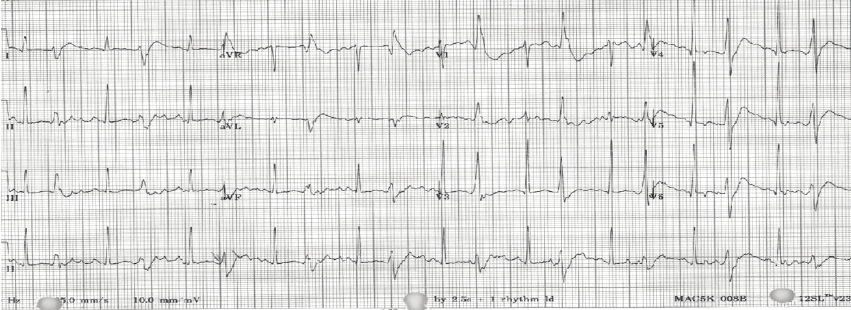
Figure 1: Initial EKG showing bigeminy—showing increased cardiac muscle excitability with origination of ventricular ectopics.